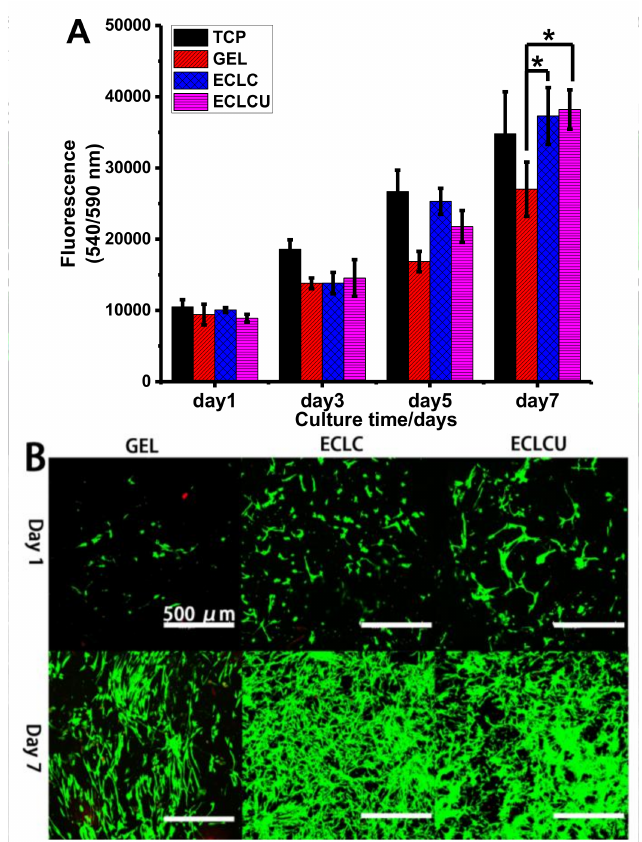
Figure 7. Survival and proliferation of human dermal fibroblasts (HDFs) on collagen matrix. ( A ) Proliferation (PrestoBlue™ cell viability indicator) of HDFs on tissue culture plate (TCP), GEL, ECLC and ECLCU matrices (* indicates statistical significance at p < 0.05 compared with cell numbers on GEL); ( B ) Live (stained by Calcein AM in green) and dead (stained by propidium iodide in red) HDFs at day 1 and day 7 (scale bar applied to all